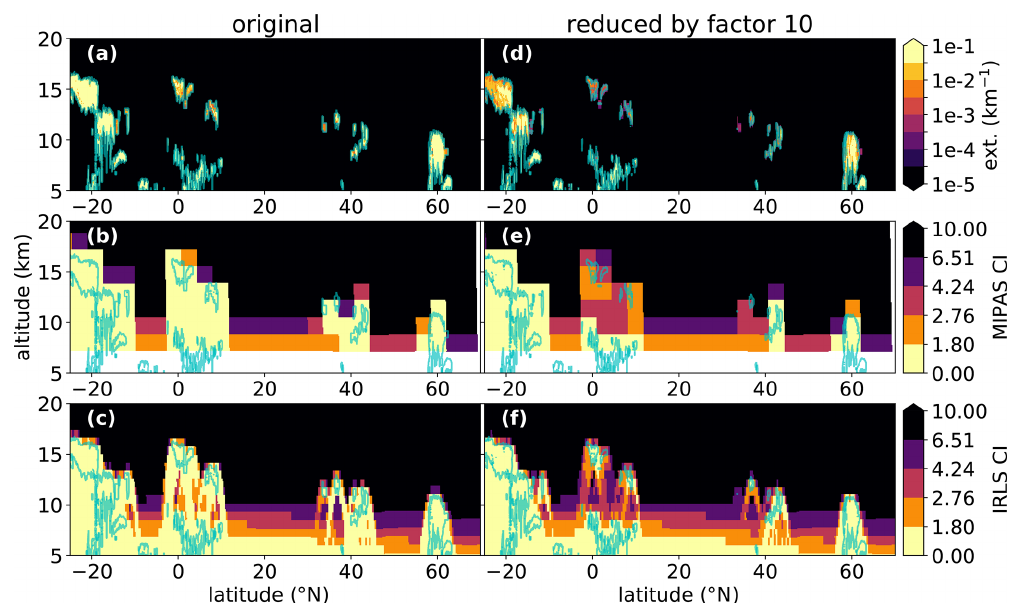
Figure 2. CALIOP extinction (a) and CALIOP extinction reduced by a factor of 10 (d) (measured on 1 December 2009 from 03:37:36UTC onward) as well as the associated CI derived from simulated MIPAS measurements in (b, e) . The CI derived from simulated IRLS measure- ments is given in (c, f) , respectively. The contour line for an extinction value of 10 − 3 km − 1 is shown as a light blue line in all panels. The satellite looks northwards in these